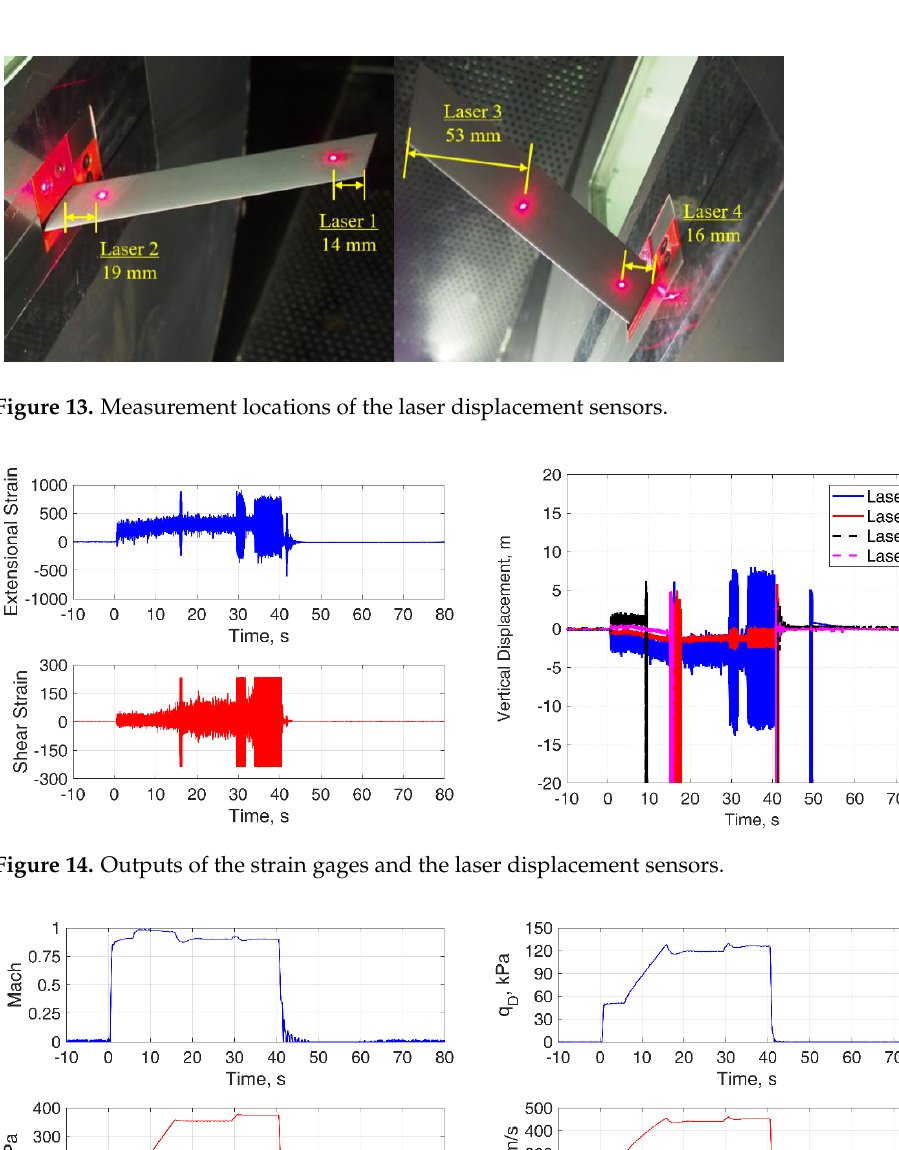
Figure 12. Wind tunnel test setup.